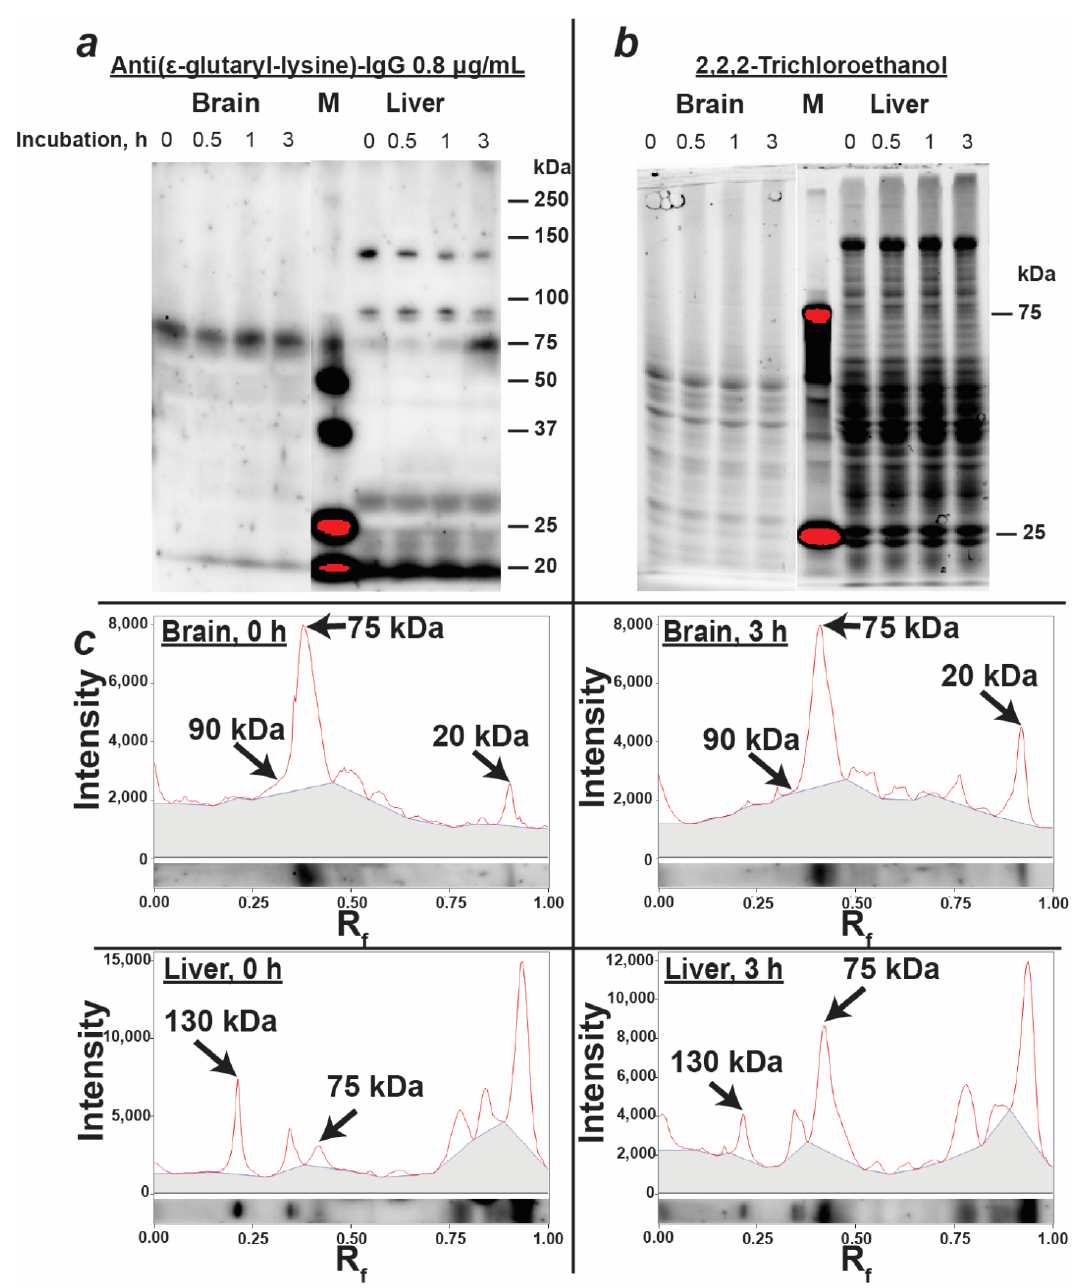
Figure 4. Detection of glutarylated proteins in homogenates of the cerebral cortex and liver of male rats aged 8–9 weeks by immunoblotting using anti-( ε -glutaryl-lysine) antibodies. ( a ) Immunovisualization of glutarylated proteins of the cerebral cortex and liver homogenates on the PVDF membrane; ( b ) visualization of proteins of the homogenates in SDS-PAGE before transfer onto the membrane; ( c ) densitograms of bands of glutarylated proteins of the rat brain and liver homogenates without incubation and after 3 h of incubation under conditions specified in Materials and Methods; the arrows show the peaks corresponding to the proteins mentioned in the text with a molecular weight of 75, 90 and 130 kDa and a low molecular weight band (20 kDa); grey color corresponds to the background staining contributed by adjacent lanes. M—protein markers with known molecular weights indicated at the right side of the blots.